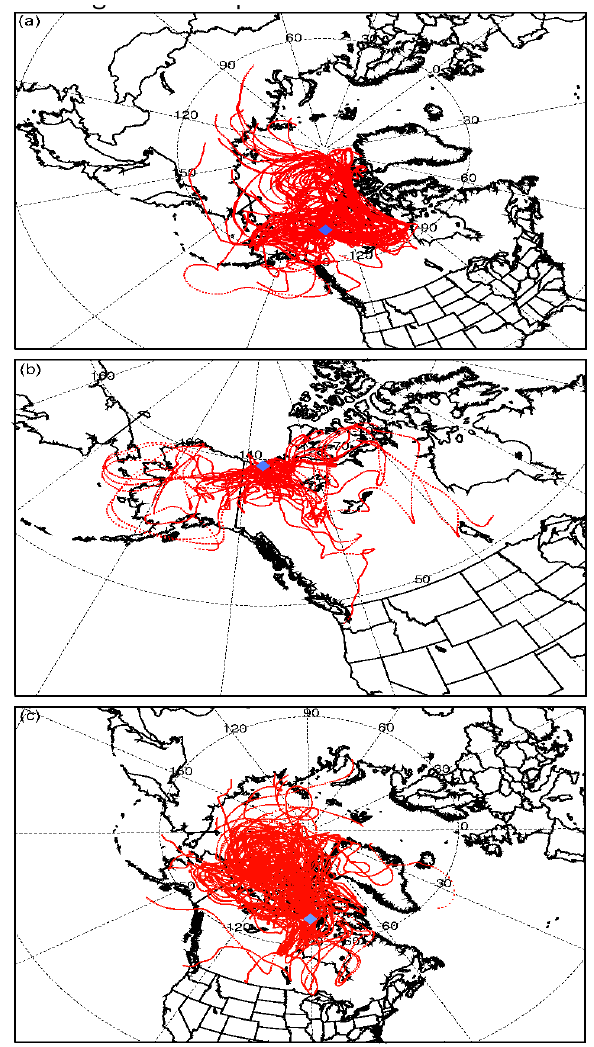
Figure 14. Location of biomass fires in west-central North America based on the MODIS Fire Mapper (Giovanni program) for October-November of 2008. The